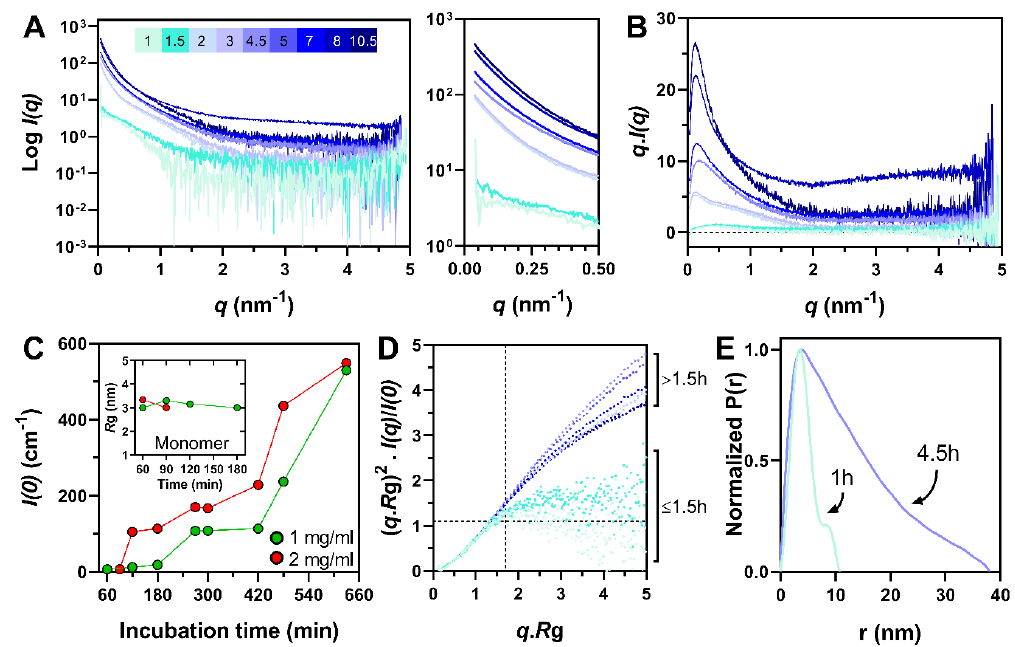
Figure 6. PNT3 aggregation process followed by SAXS. ( A ) Scattering intensities of PNT3 at 2 mg mL − 1 (132 µ M), recorded from 1 h to 10.5 h of incubation at 37 ◦ C. A zoomed-in view of the low-angle region is shown on the right. ( B ) Total scattering intensities. The color code is the same as in ( A ). ( C ) Zero-angle scattering intensities ( I (0)) as a function of the incubation time. Insert: estimated R g for the monomeric species. ( D ) Normalized Krakty plot. The black dotted lines indicate the maximum of a bell-shaped curve as observed for globular proteins. The color code is the same as in ( A ) and ( B ). ( E ) Normalized pairwise distance distribution functions of PNT3 incubated for 1 h and 4.5 h.